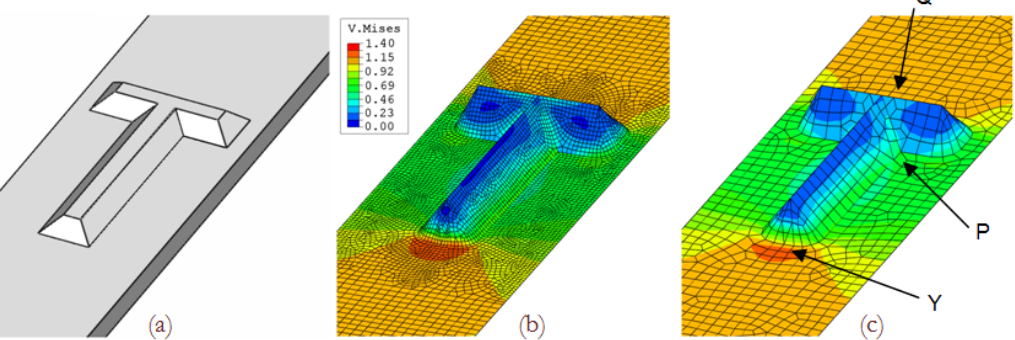
Figure 7: a) Specimen with the T-shaped attachment; b)-c) shell models with different mesh size. The V.Mises stress is normalized by the nominal tensile stress.